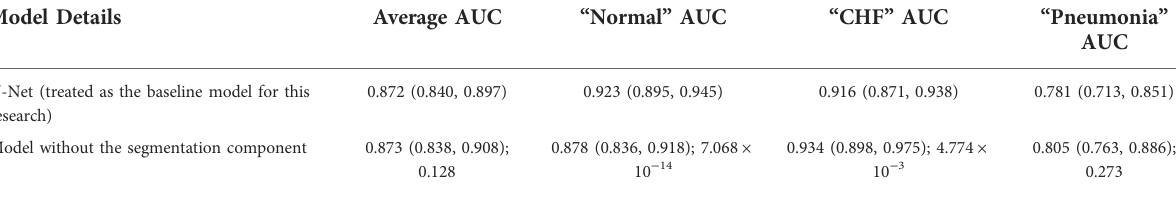
TABLE 1 Comparing the AUC values between (12) ’ s baseline model with no segmentation component and the U-Net architecture (the value preceding the parenthesis is the 50th percentile value and the values in parenthesis are 2.5th and 97.5th percentile values, and the value after a semicolon is the p